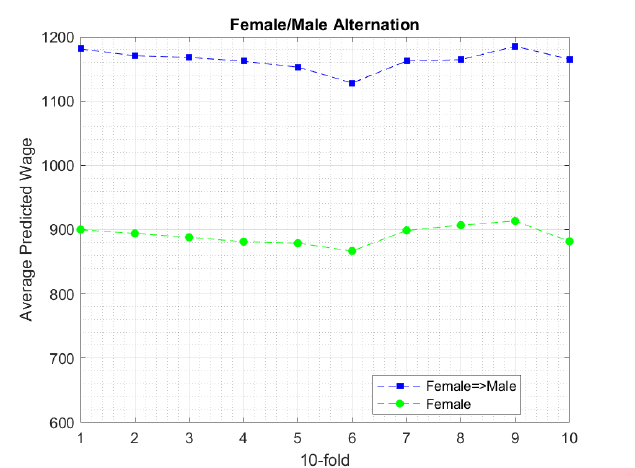
Figure 2. Female to male alternation. It shows that the female wage (in green) improves when the gender is changed to male (in blue).